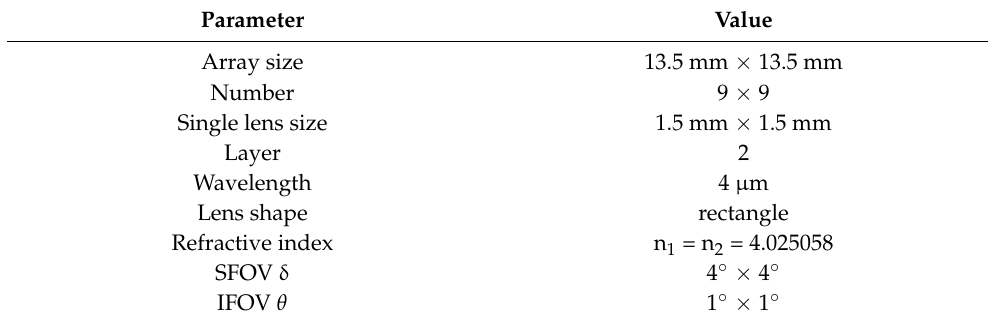
Table 1. Parameters of the array system.